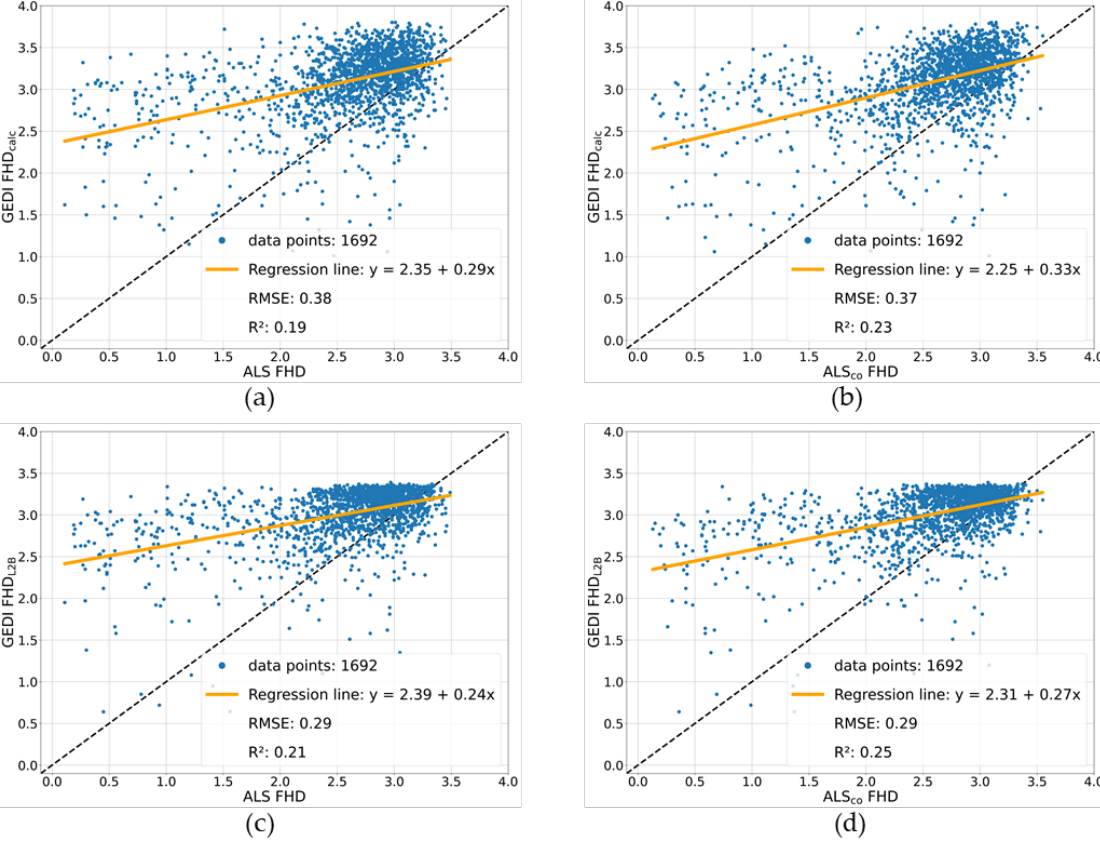
Figure 6. ALS FHD and GEDI FHD calc ( a ) before and ( b ) after the co-location, and ALS FHD and GEDI FHD L2B ( c ) before and ( d ) after the co-location. For the statistical analysis, Python module “statsmodels” is used.